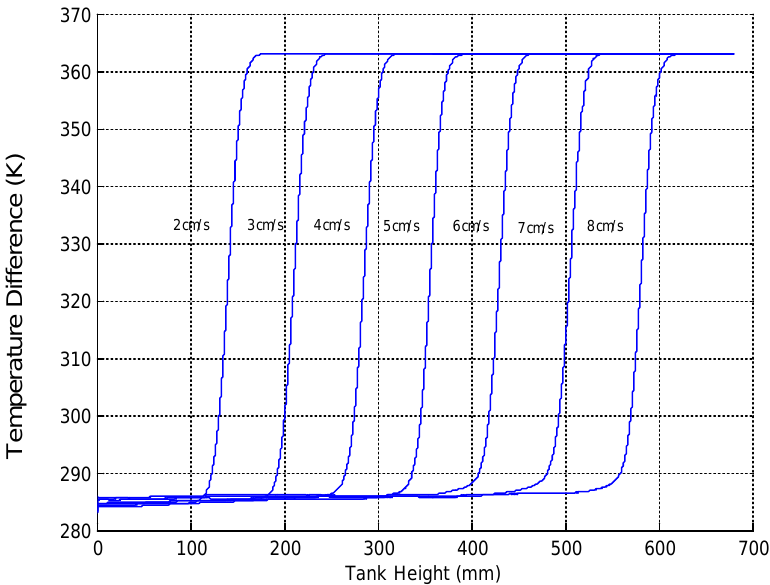
Figure 11. Temperature profiles in TES-1 at different inlet velocities: non-dimensional temperature difference versus tank height. Table 2. Summary of the results: thermocline formation.